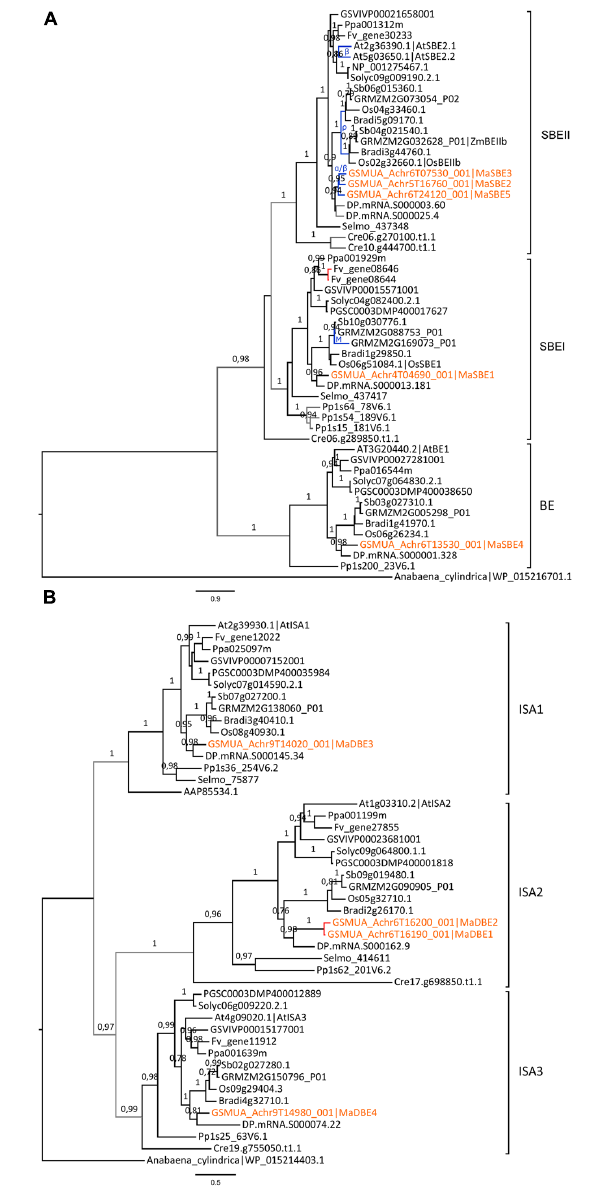
FIGURE 5 | Phylogenetic trees of branching and debranching enzymes (SBE and DBE) families. (A) Maximum likelihood tree of SBE predicted proteins. (B) Maximum likelihood tree of DBE (ISA) predicted proteins. Trees were rooted using Anabaena cylindrica SBE and DBE sequences, respectively. The different subclades are indicated on the right. Branch supports > 0.70 (aLRT statistics with SH–like procedure) are indicated. Chlamydomonas reinhardtii (Cre), Physcomitrella patens (Pp), Selaginella moellendorffii (Selmo), grapevine (GSVIV), tomato (Solyc), potato (PGSC), woodland strawberry (Fv), Arabidopsis (At), peach (Ppa), Brachypodium (Bradi), rice (Os), maize (GRMZM), sorghum (Sb), date palm (DP) and banana (GSMUA) identifiers are indicated (in brown for banana). AAP85534.1 and NP_001275467.1 are a C. reinhardtii and a potato sequence from Genebank, respectively. Branches are colored according to gene duplication modes: WGD (blue), proximal (red) and unknown (gray). WGD events identified using reconstructed ancestral blocks are indicated (blue letters). Black branches correspond to speciation events. Scale bars represent the estimated amino acid substitutions per